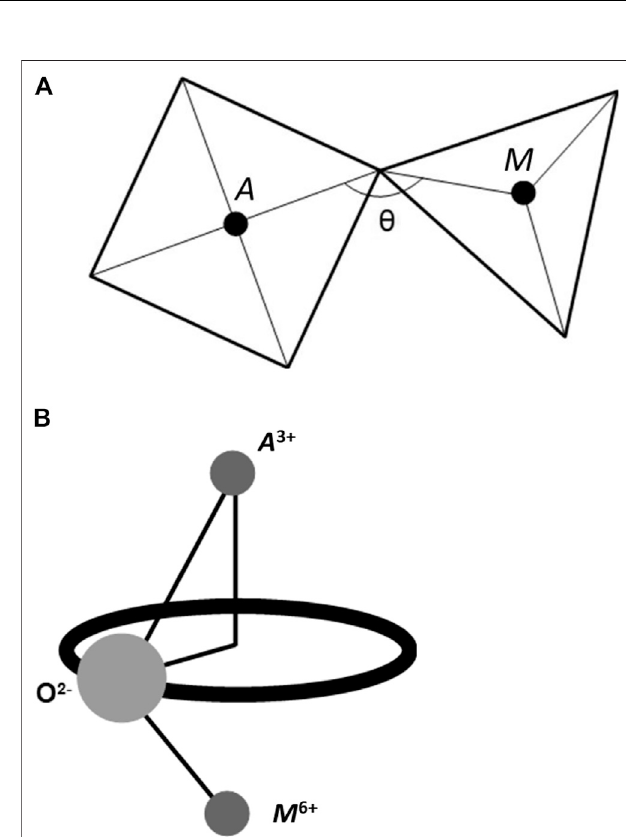
FIGURE 4 | (A) Contraction of the A − M non-bonding distance and decrease of the A − O − M angle ( θ ) in the octahedron-tetrahedron local structural motif in an A 2 M 3 O 12 structure, arises with increasing temperature due to the asymmetric transverse vibration of the 2-fold oxygen at the shared vertex, and leads to negative thermal expansion. (B) Transverse thermal vibrations of 2-fold oxygens in the A 2 M 3 O 12 family, describing a torus geometrical fi gure, causing reduction of the apparent bond distances ( A 3+ − O 2- and, especially, M 6+ − O 2-